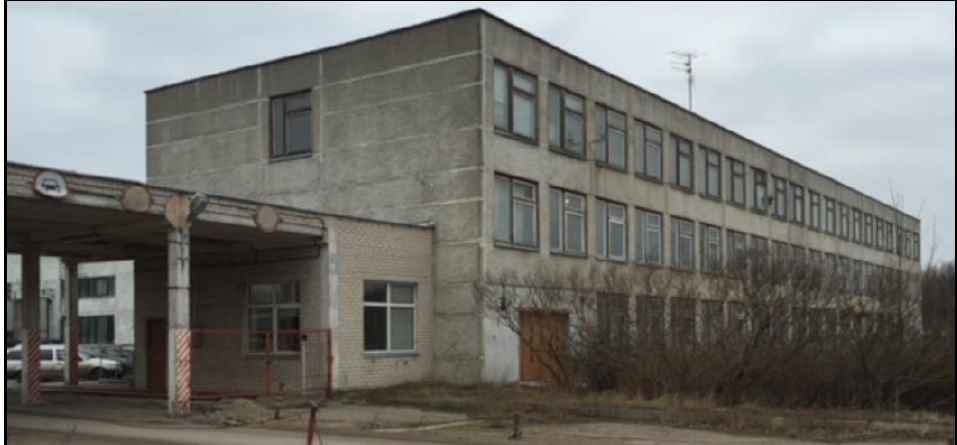
Figure 1. Building before reconstruction (“D” building) .